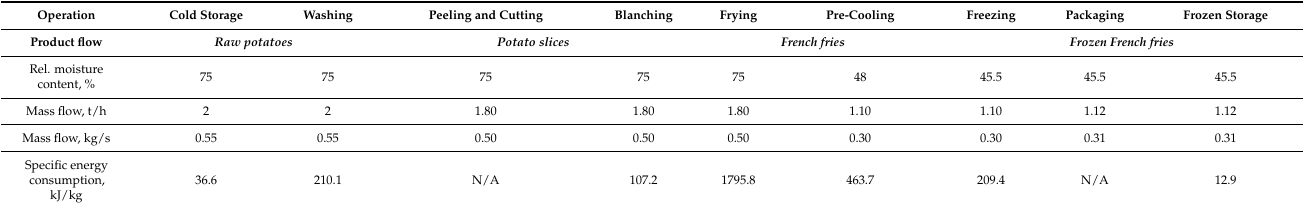
Table 1. Production line for processing and storage of frozen French fries—mass flows and specific energy consumption for the considered unit operations.